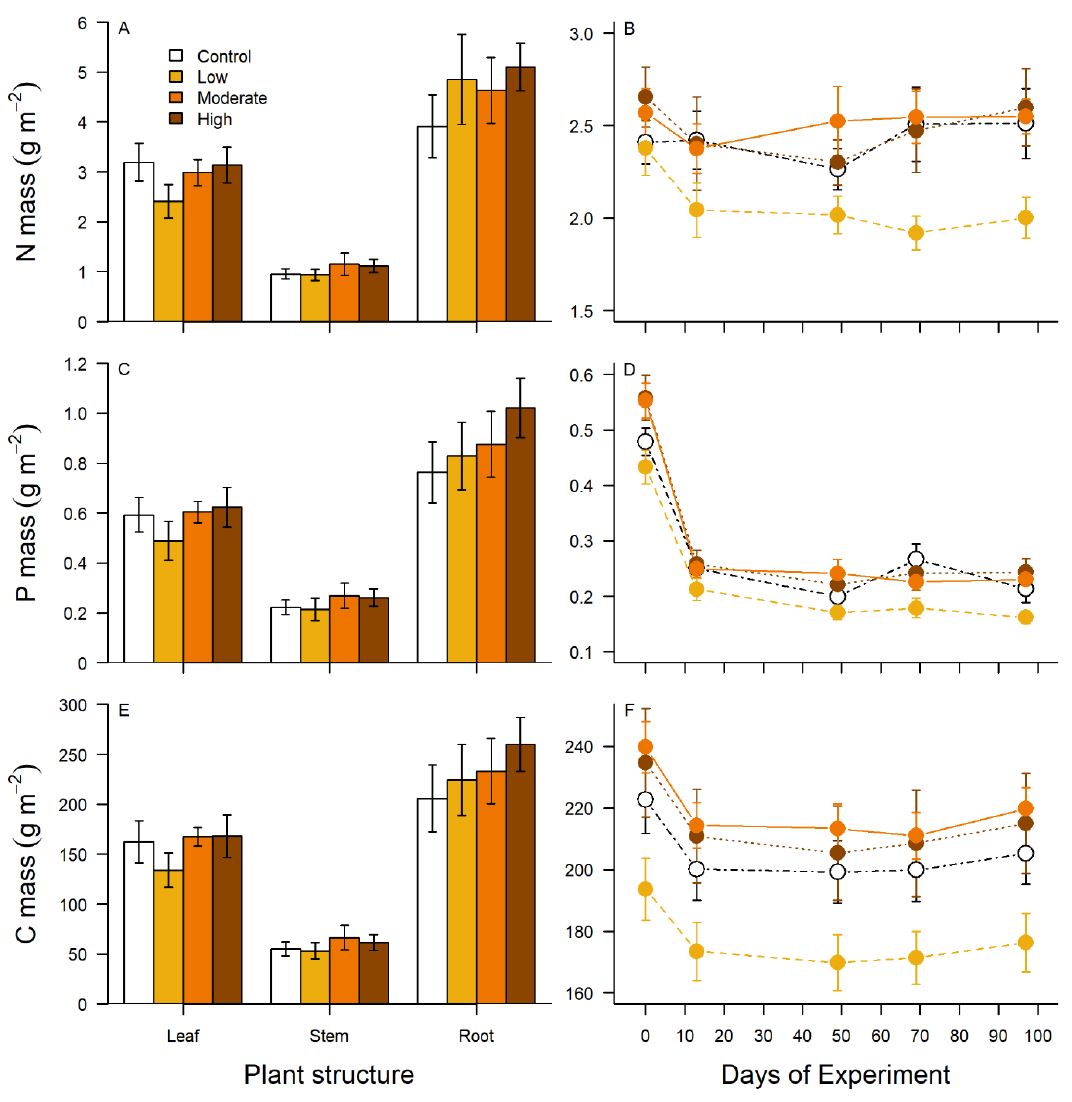
Figure 3. Mean ( ± SE) mesocosm nutrient mass for N, P, and C across P enrichment treatments and plant structures ( A , C , E ). Additionally, mean ( ± SE) mesocosm aboveground (leaf and stem) N, P, and C mass over time across P enrichment treatments during the decomposition process ( B , D , F ).